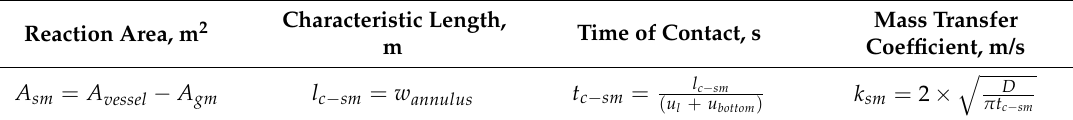
Table 2. Evaluation of mass transfer parameters at slag-metal bulk (slag-metal interface). Reaction Area, m